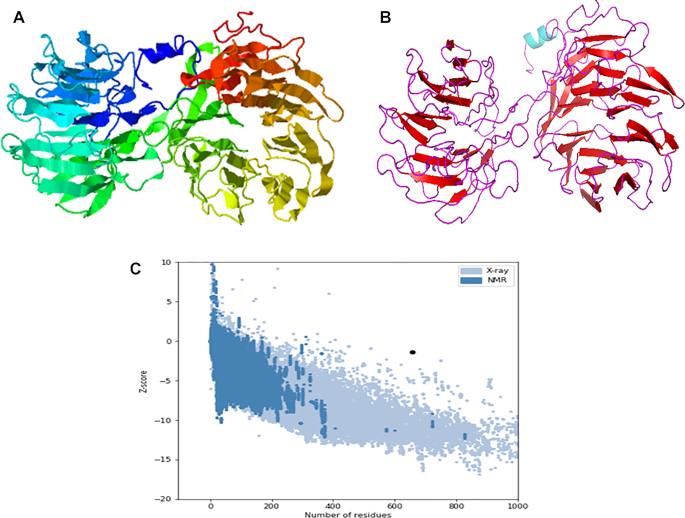
The vaccine protein 3D structure modelling, refinement and validation. (A) The crude final 3D model of the multiepitope vaccine obtained from the I-TASSER server before refinement. (B) The refined 3D protein vaccine structure as obtained from GalaxyRefine. (C) Validation of the refined model with ProSA-web, showing a Z-score of −1.38.